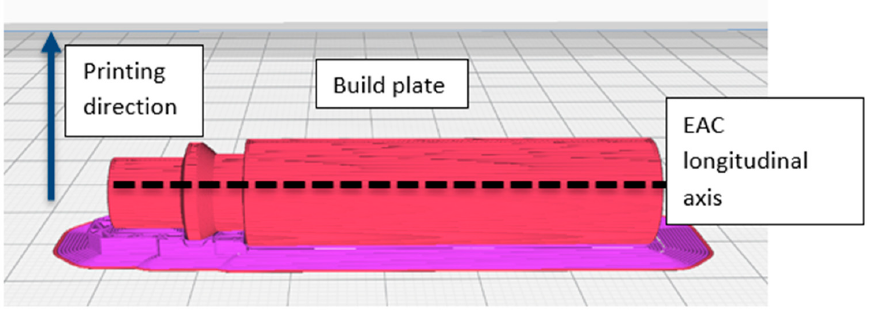
Figure 4. Second printing orientation; the purple parts are the supports made from polyvinyl alcohol (PVA).